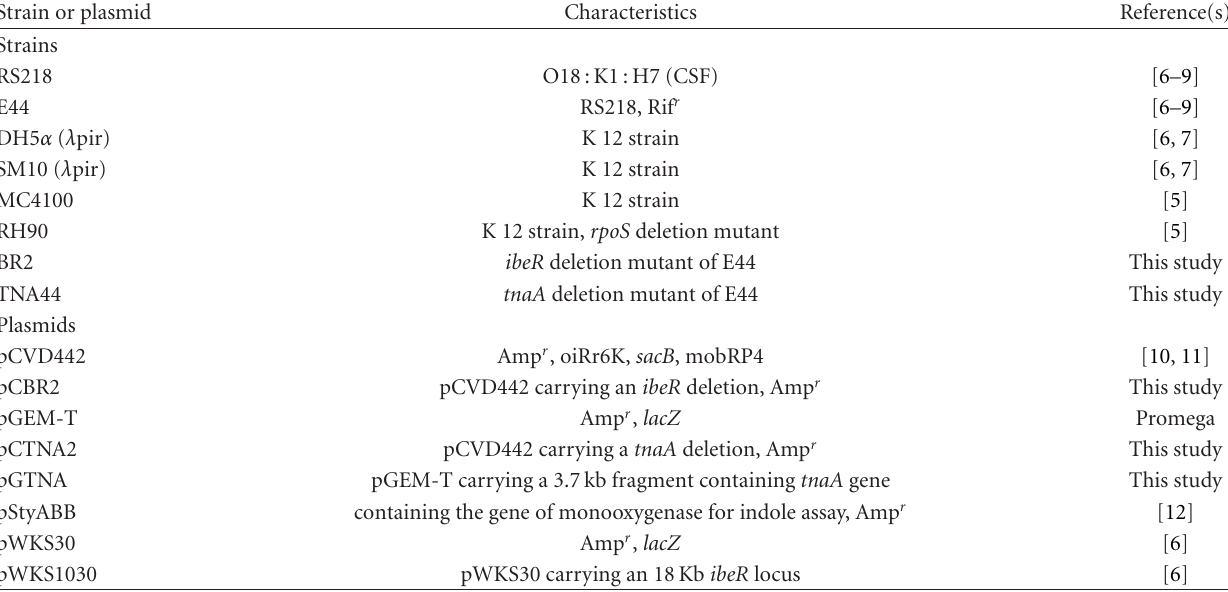
Table 1: E. coli K1 (meningitic) or K12 (nonpathogenic) strains and plasmids used in this